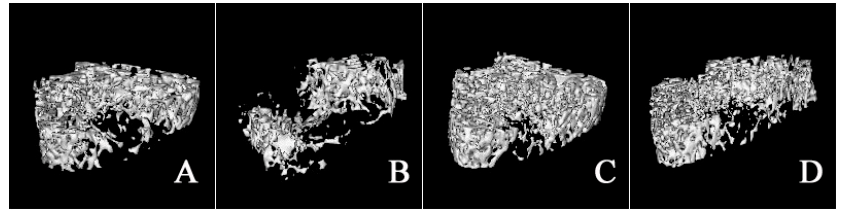
Figure 3. Representative 3-D images of bone trabeculain the distal femoral metaphysic region: ( A ) CON; ( B ) HLS; ( C ) HLS-ALE; ( D ) HLS-RSE ( n = 6). CON: control group; HLS: hindlimb suspended group; HLS-ALE: group administrated with alendronate (2 mg/kg/day); HLS-RSE: group administrated with Radix Scutellariae extract (50 mg/kg/day).